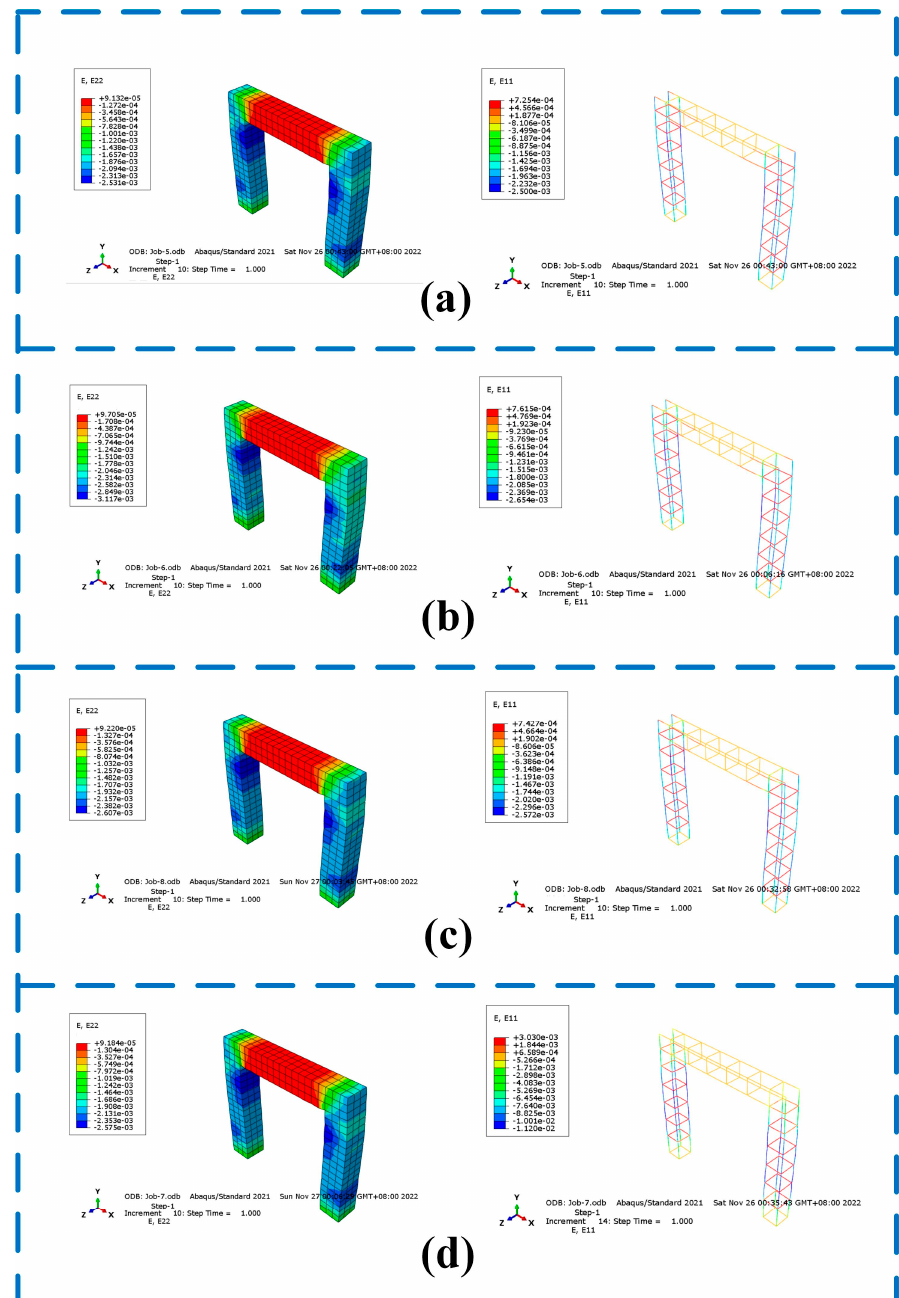
Figure 14. Strain cloud diagram of four frame structures: ( a ) ordinary concrete frame model; ( b ) rubber concrete frame model; ( c ) PVA rubber concrete frame model; ( d ) modified PVA rubber concrete frame model.